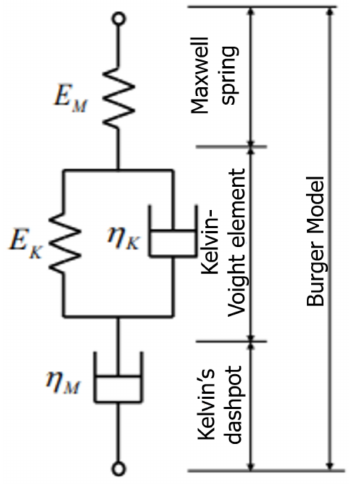
Figure 6. Schematic diagram of physical Burger